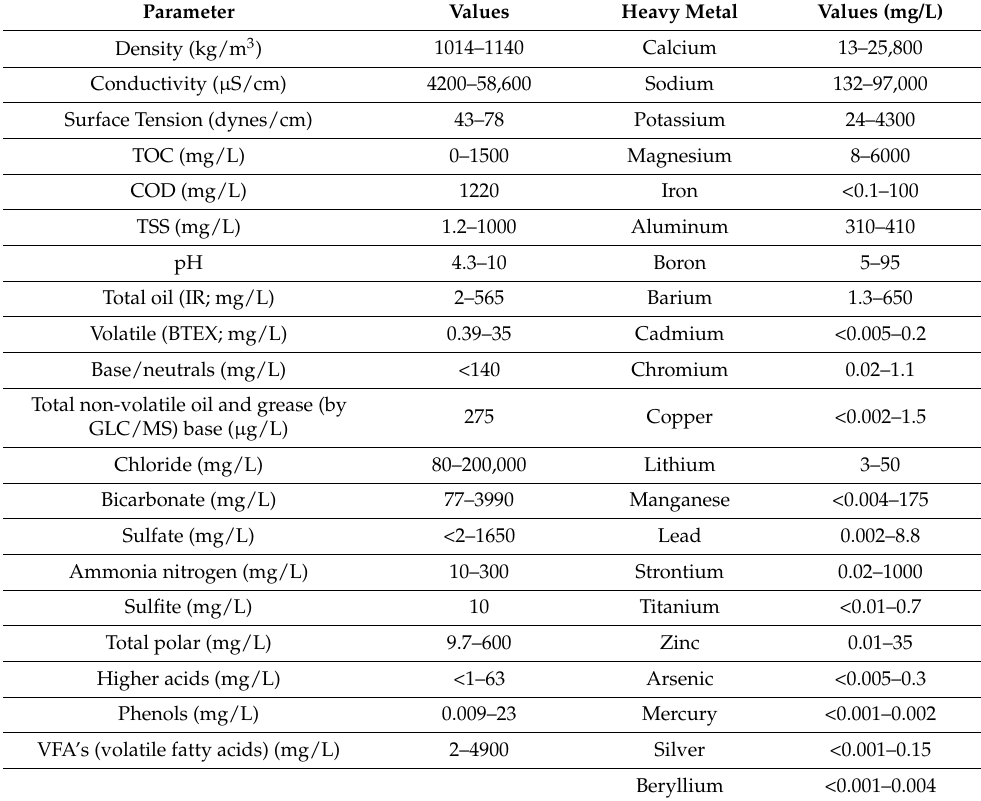
Table 1. A summary of the composition of produced water from various oil fields [51,56] (reproduced with